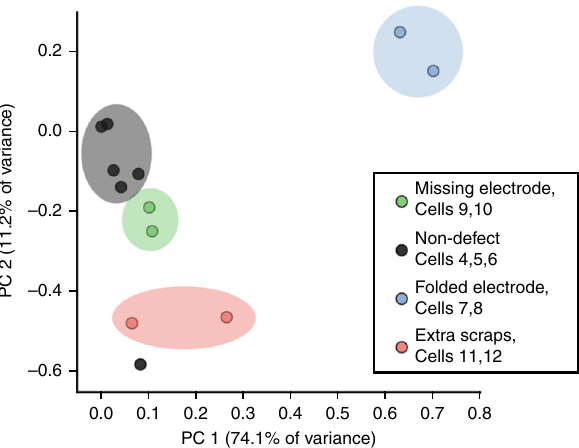
Fig. 5 Principal component analysis performed on the magnetic fi eld maps of the cells shown in Fig. 4. This analysis shows the grouping of cells into normal cells and cells with particular defects